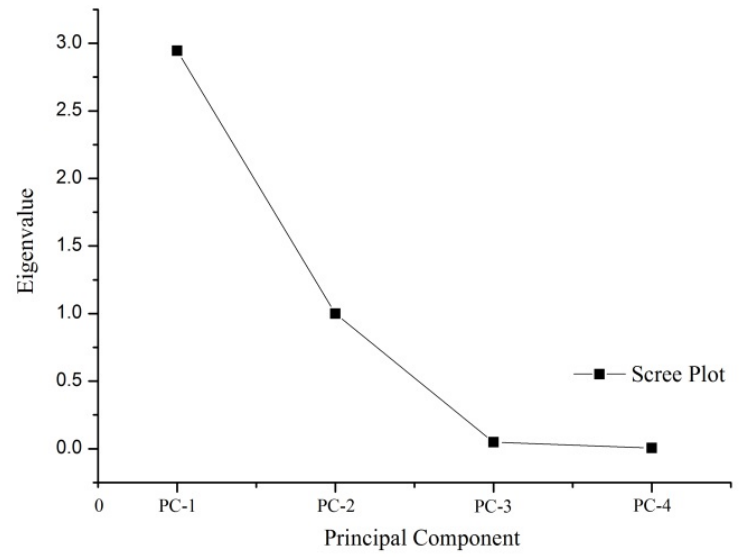
Figure 3. A PCA scree plot. Table 8. Variance and cumulative contributions of PC-1, PC-2, PC-3, and PC-4. Components